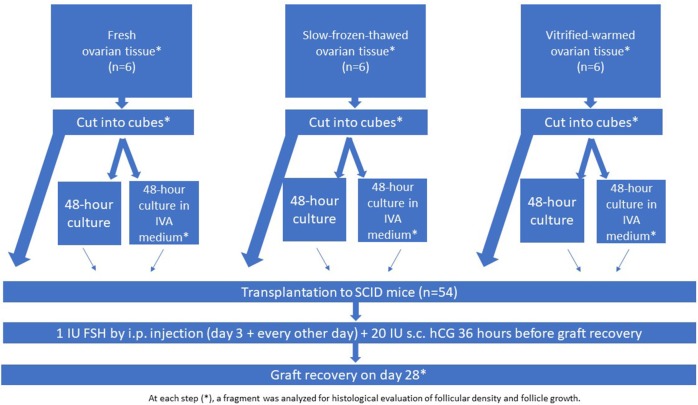
Experimental design.